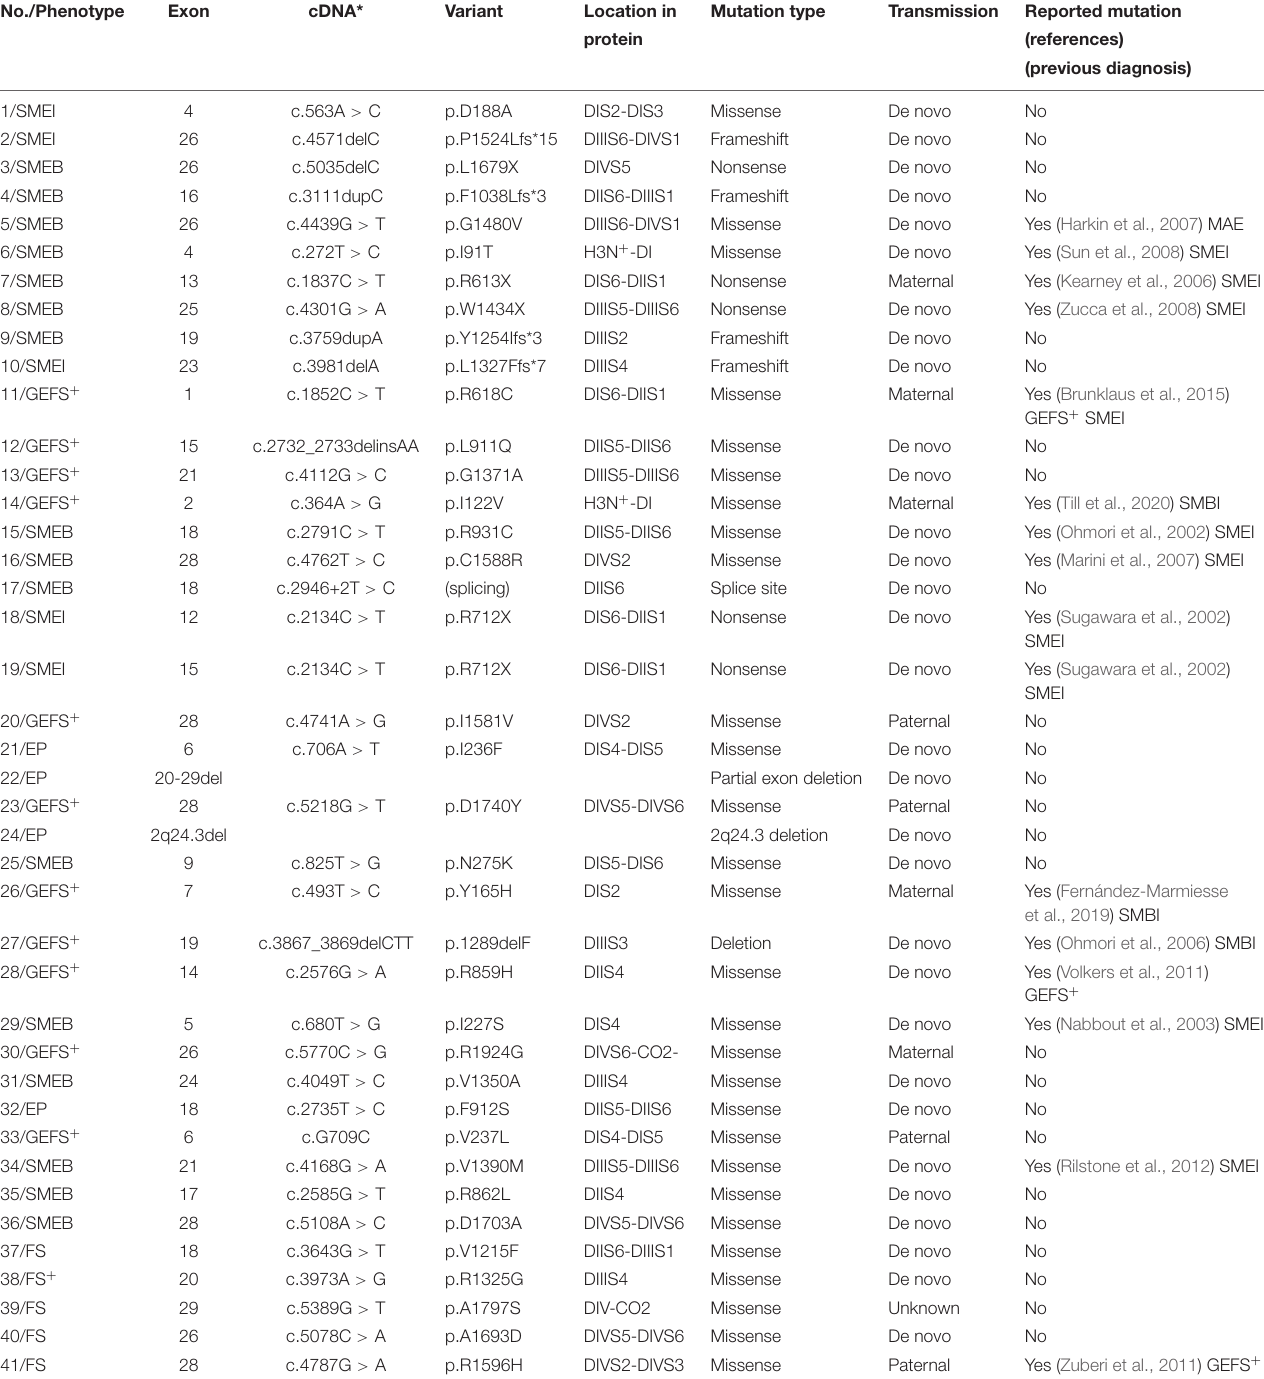
TABLE 3 | Genetic characteristic of 41 SCN1A variants identified in this